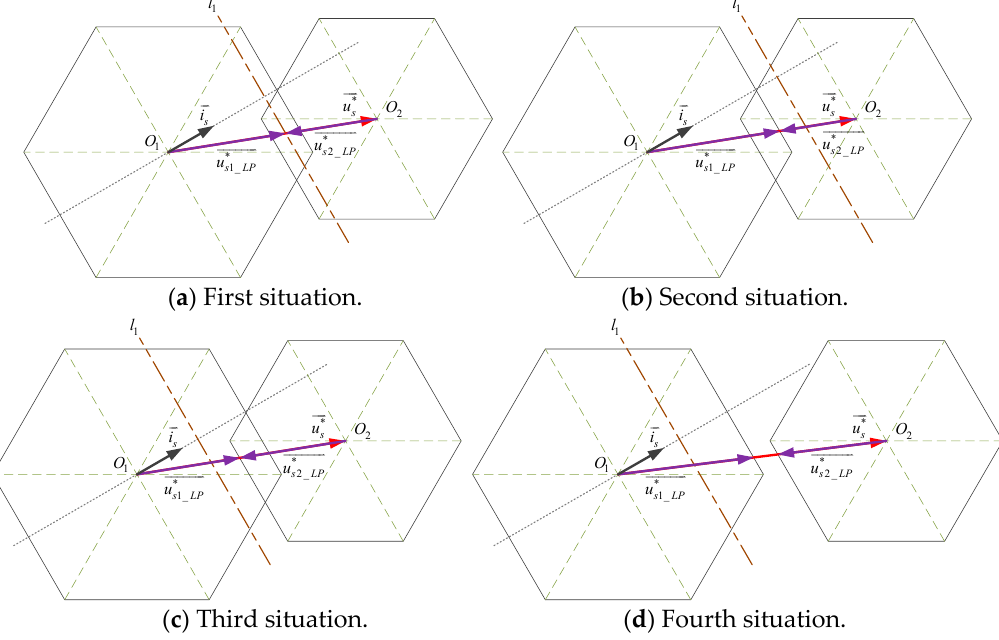
Figure 8. Voltage vector distribution examples of linear partition method.